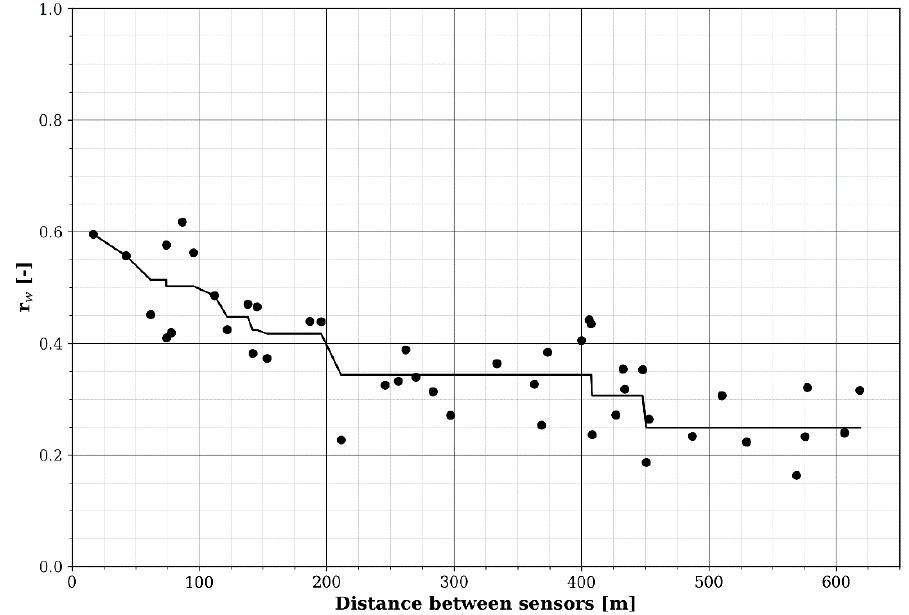
Figure 15. Weighted correlation between fixed RF-EMF sensor pairs as a function of the distance between them. The black line is an isotonic regression.